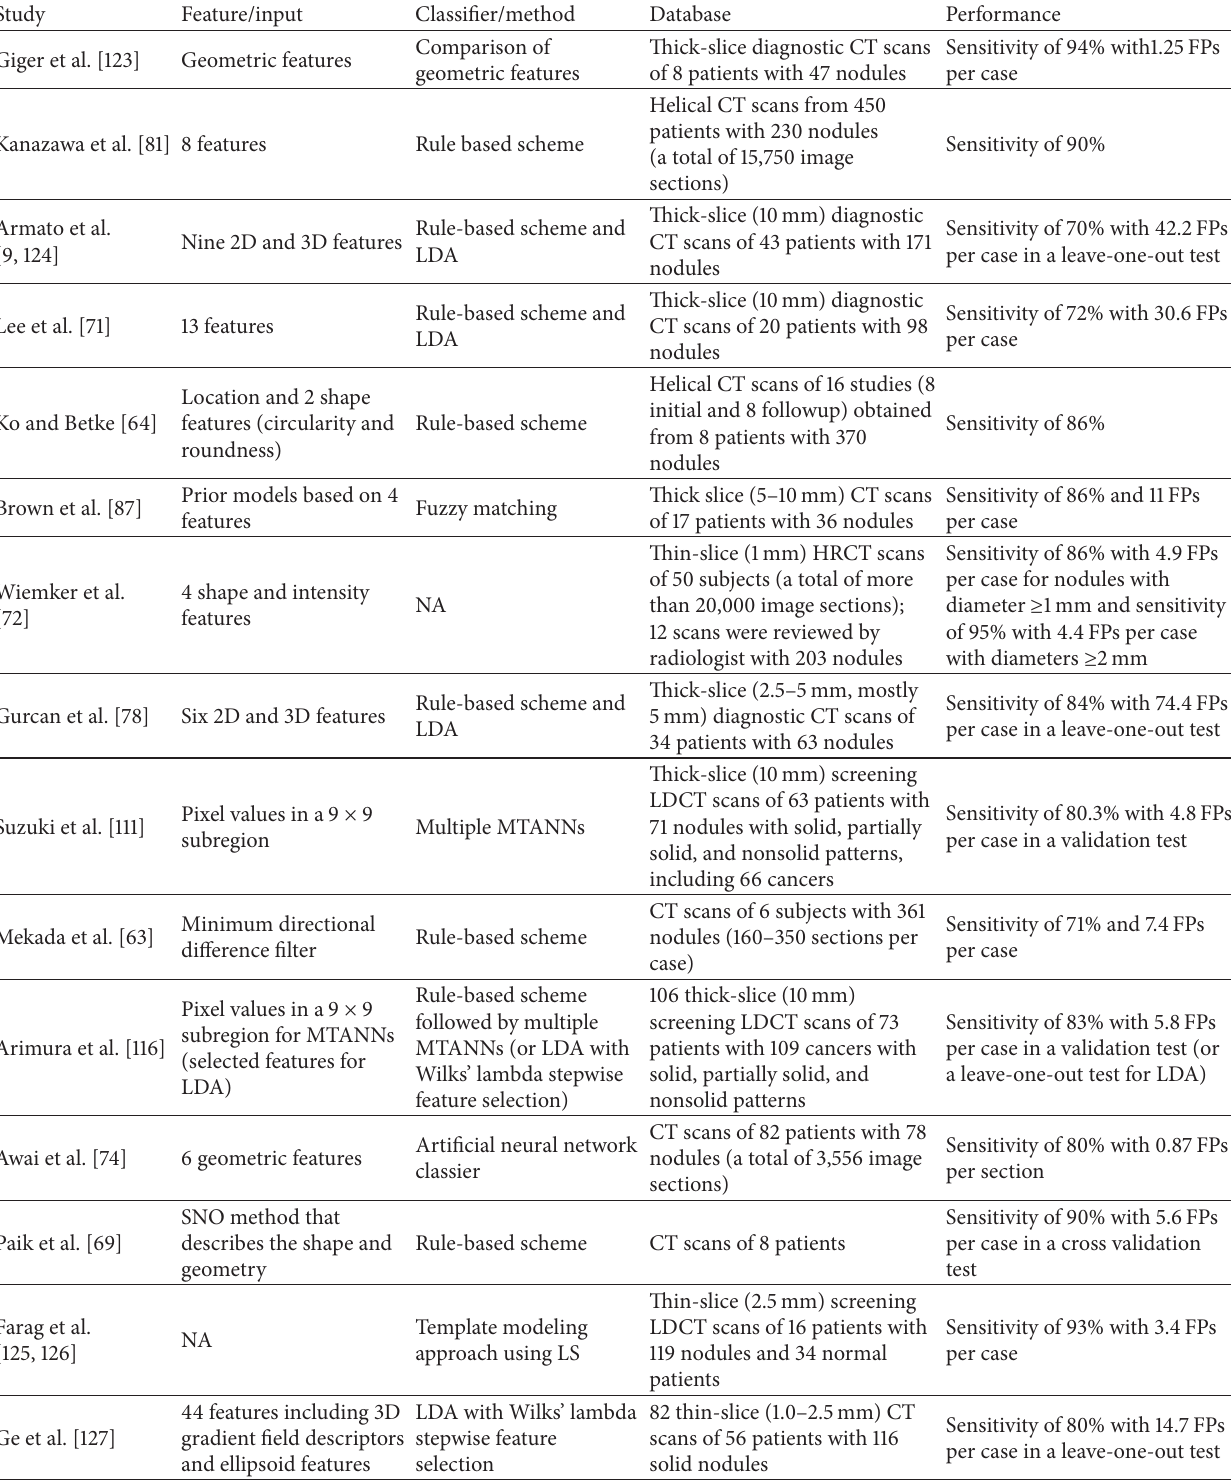
Table 2: Classification component in CADe systems. Studies are ordered by their publication